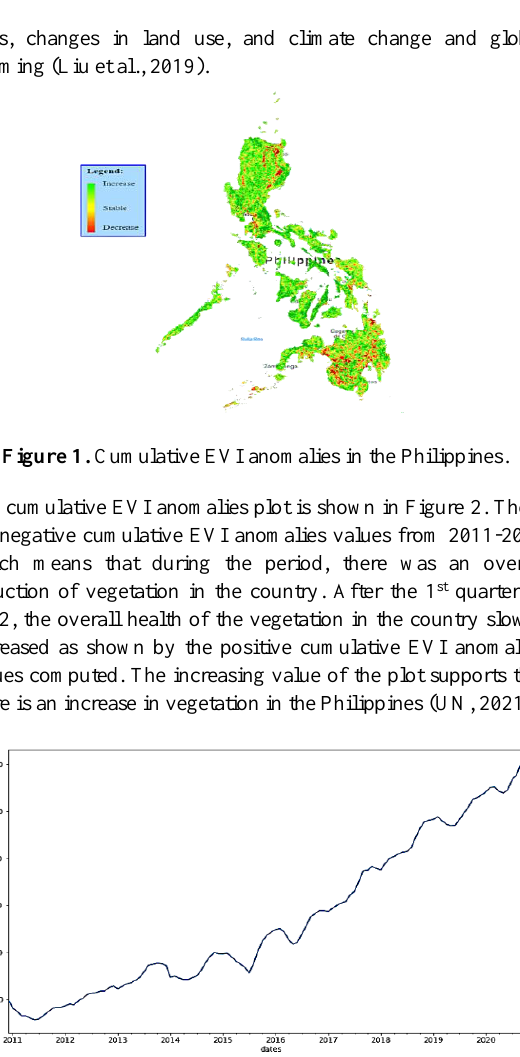
Figure 2. Cumulative EVI anomalies plot of the Philippines for